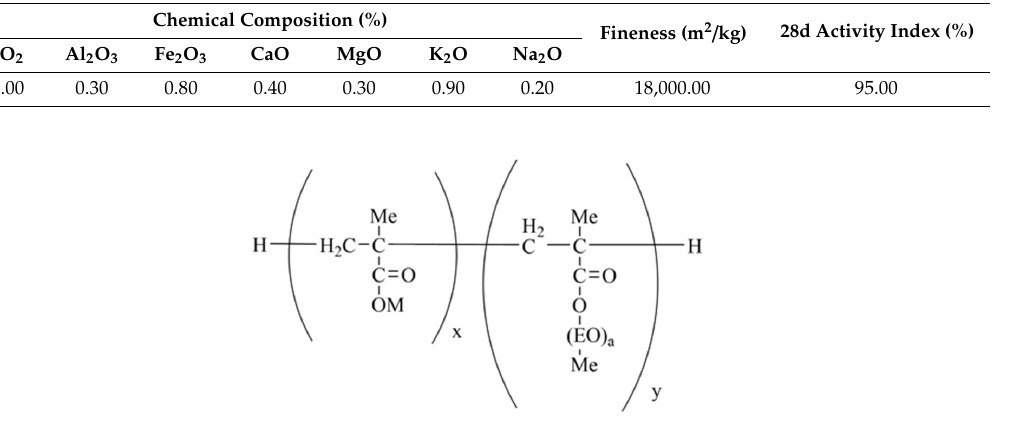
Figure 1. The molecular formula of polycarboxylic acid. Table 4. Chemical composition of Cement.